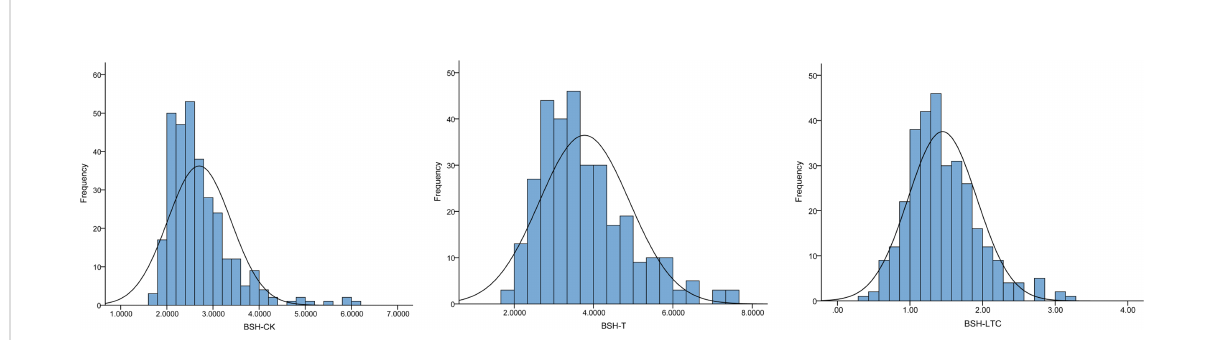
FIGURE 1 Frequency distribution of BSH under different conditions. BSH, root bushiness; CK, normal condition; T, Pb treatment; LTC, lead-tolerance coef fi